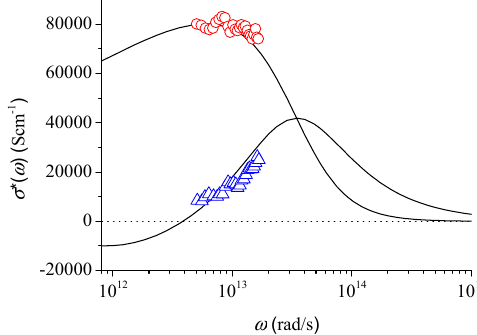
Figure 7. Complex conductivity in nanostructured Au films. Open circles and triangles are the experimental data extracted from [30]. Solid lines are the conductivity predicted by the SSFTC model.